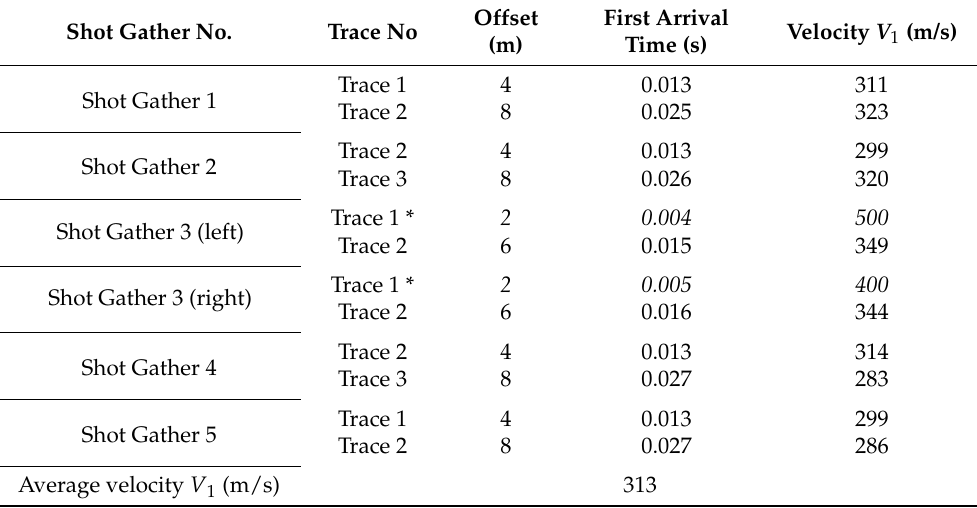
Table 1. First arrival travel times of direct wave and corresponding offsets and velocities from all shots of the survey. The two traces from shot gather 3 (marked by *) have been excluded from averaging because they were considered outliers.